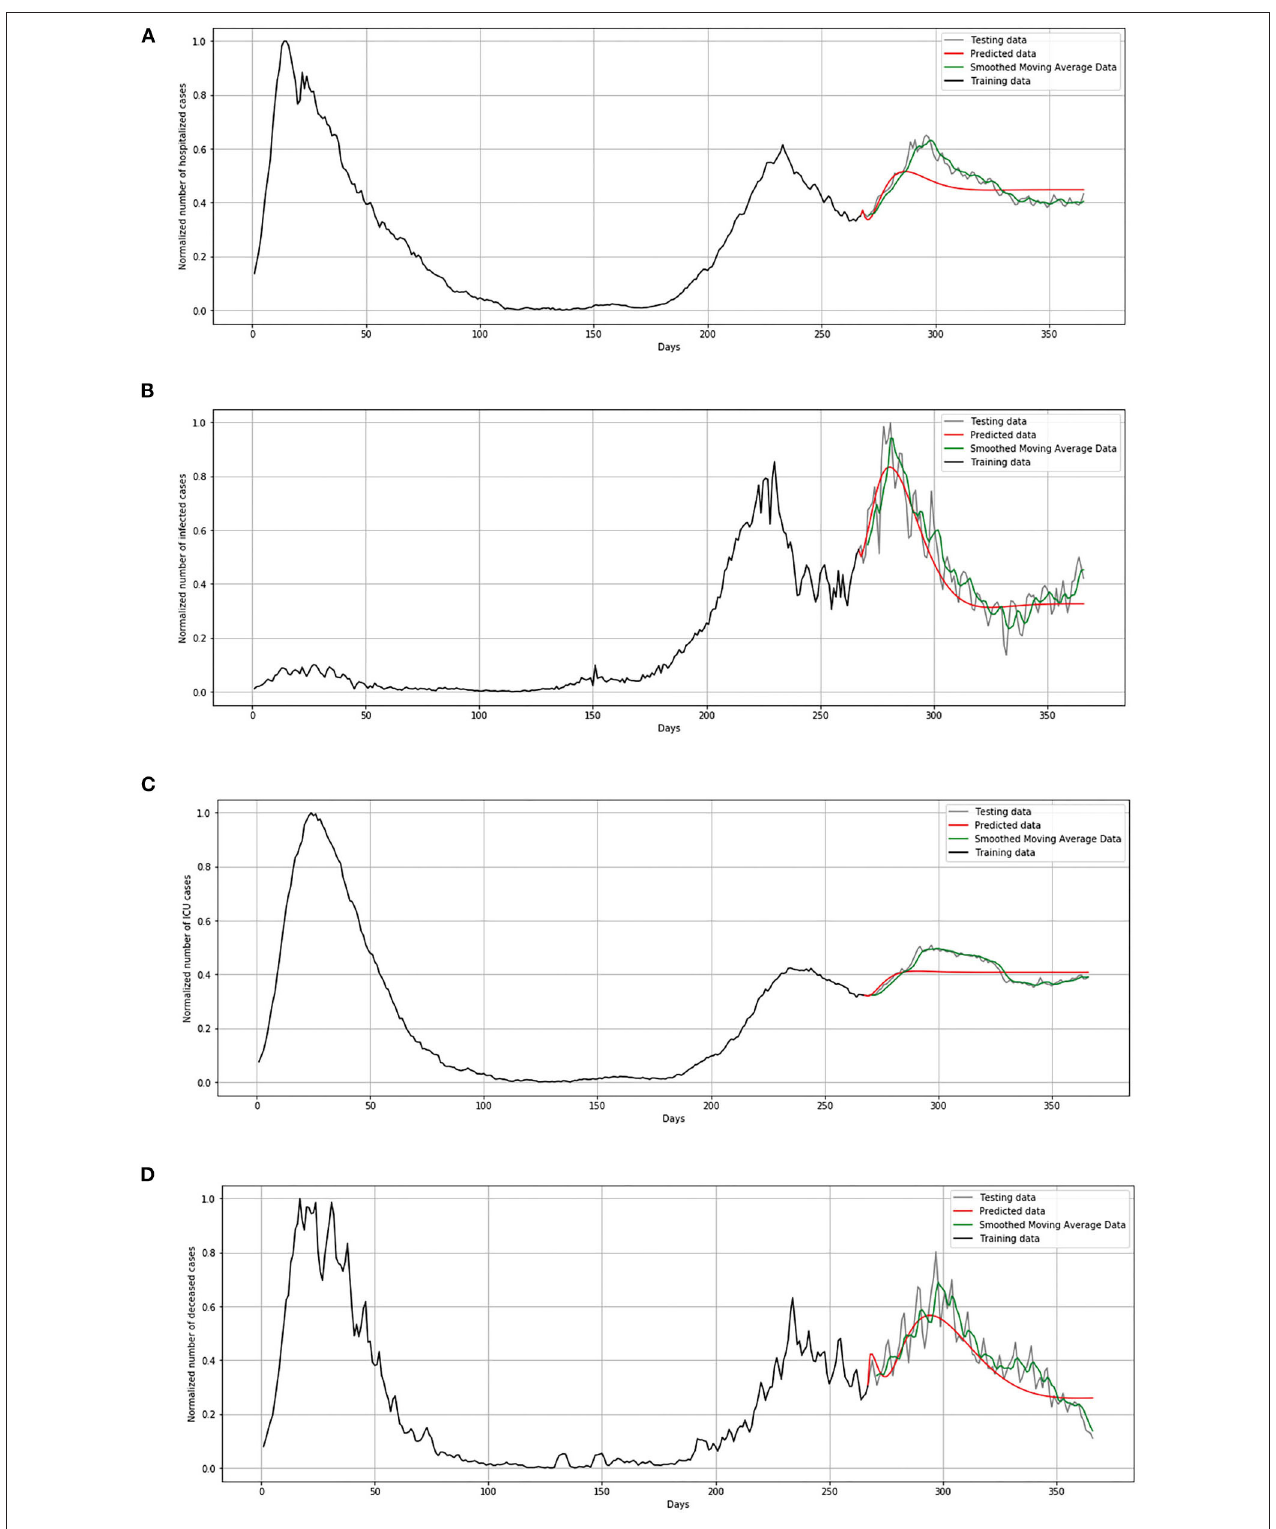
FIGURE 13 | Comparison of real and simulated values for Netherlands: (A) number of infected cases, (B) number of hospitalized cases, (C) number of ICU cases, (D) number of deceased cases.